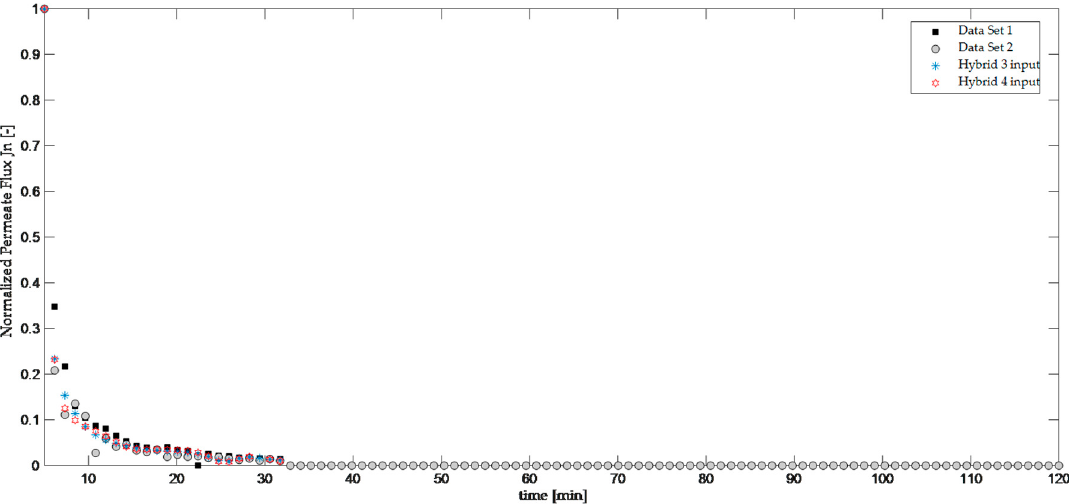
Figure 7. Comparison between the normalized permeate flux from both experimental data sets and the normalized permeate flux from the hybrid model from the theoretical approach and the ANNs developed with three and four inputs.